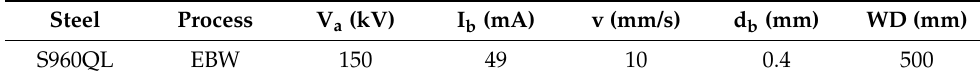
Table 3. EBW optimal parameters.